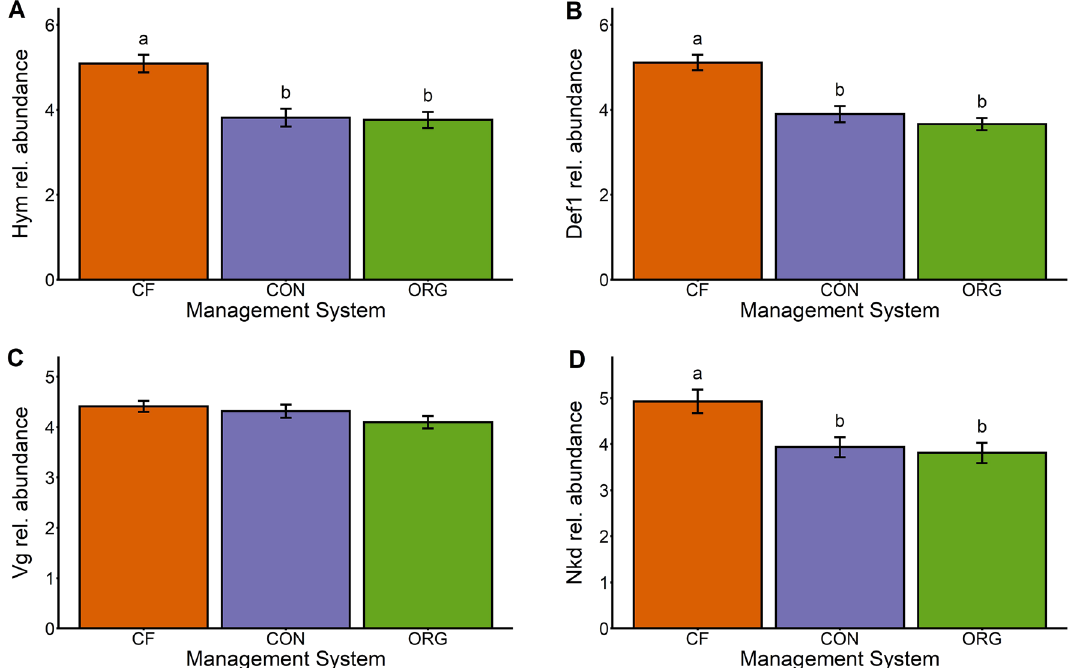
Figure 5. Summary of the differences in the expression of ( A ) Hymenoptaecin ( hym ), ( B ) Defensin -1 ( def1 ), ( C ) Vitellogenin ( vg ), and ( D ) Naked cuticle gene ( nkd ) in colonies under the three tested management systems; chemical-free (CF, orange), conventional (CON, blue), and organic (ORG, green). Columns with different letters are significantly different from each other (Tukey HSD p <